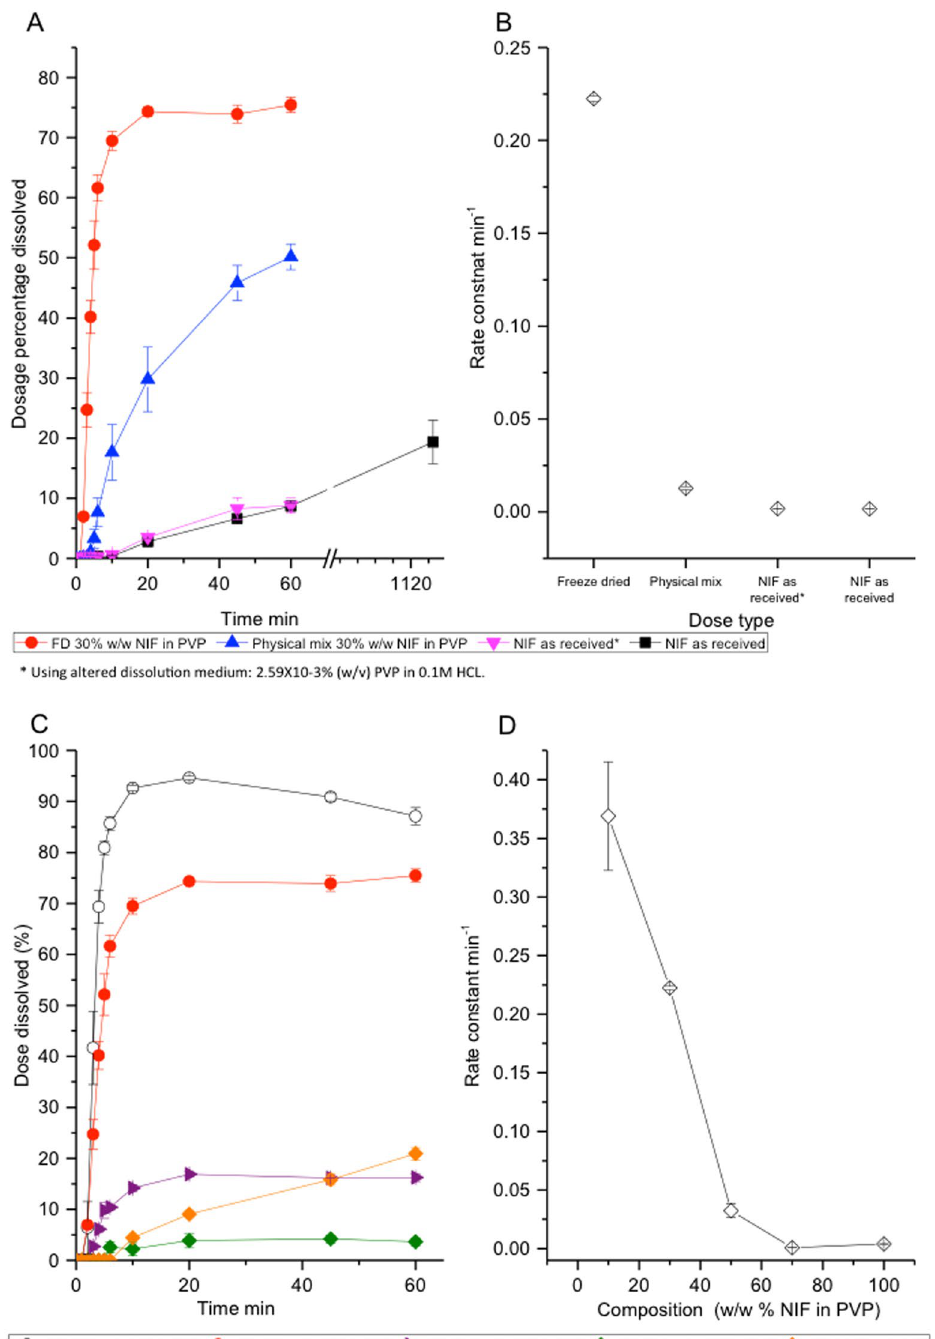
Figure 7. Comparing ( A ) dissolution profile ( B ) rate constant of nifedipine in different dosage types. The dissolution medium is 0.1 M HCl unless otherwise stated. Temperature of dissolution medium is 37.0 ± 0.5 °C and dissolution volume 900 mL. Test was performed following USP paddle apparatus 2. Error bars represent standard error of n = 3. Comparing ( C ) dissolution profile ( D ) rate constant of In situ FD nifedipine capsules with varying NIF:PVP ratios The dissolution medium is 0.1 M HCL unless otherwise stated. Temperature of dissolution medium is 37.0 ± 0.5 °C and dissolution volume 900 mL. Test was performed following USP paddle apparatus 2. Error bars represent standard error of n =